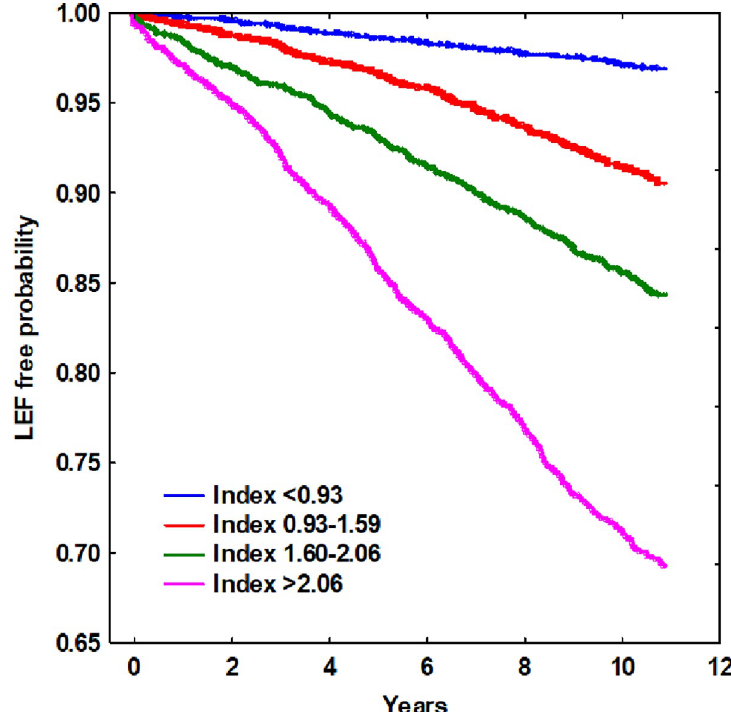
Fig 5. Low energy fracture-free probability over time in relation to KEFRI-value (quartiles).